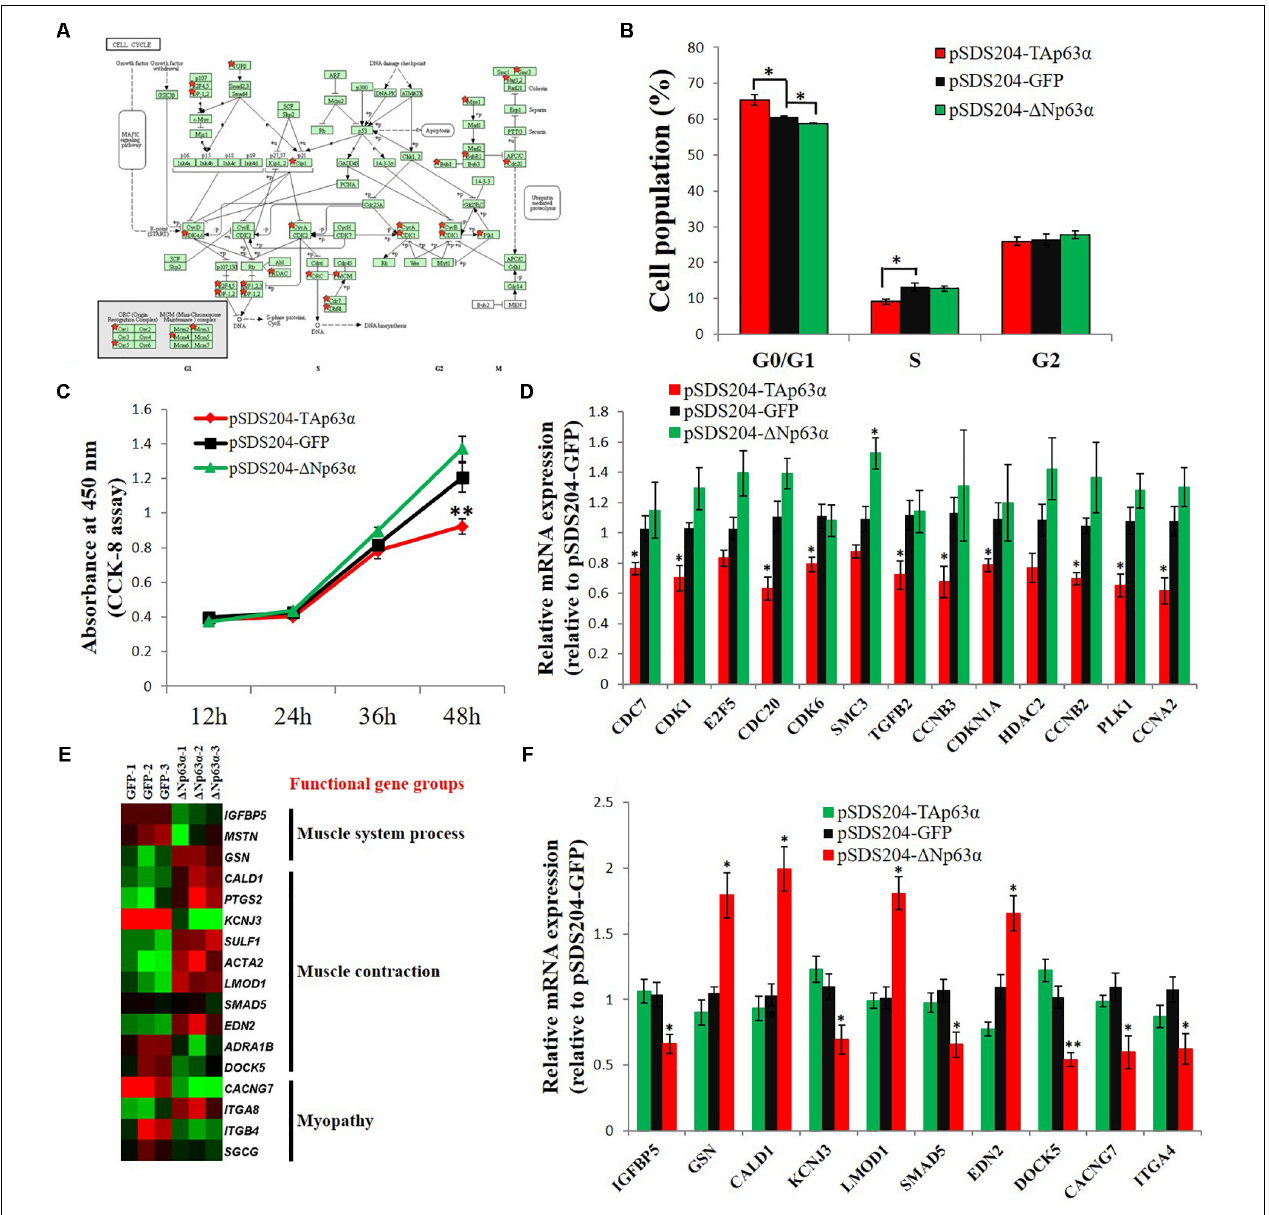
FIGURE 5 | Identification of major downstream regulatory pathways and functional gene groups of TAp63 α and (cid:49) Np63 α in myoblasts. (A) DEGs between TAp63 α overexpression myoblast and NC myoblast were enriched in the cell cycle pathway. Red stars indicate the genes that are differentially expressed between TAp63 α and NC group. (B) Myoblasts were transfected with pSDS204-TAp63 α , pSDS204- (cid:49) Np63 α , or pSDS204-GFP, followed by 48 h culture, and the cell cycle phase was then analyzed. (C) CCK-8 assay was performed to access the effects of TAp63 α and (cid:49) Np63 α overexpression on myoblast proliferation. (D) qPCR validation of the DEGs enriched in cell cycle pathway. (E) The heat-map of genes related to muscle system process, muscle contraction, and myopathy. (F) qPCR validation of the DEGs related to muscle system process, muscle contraction, and myopathy. The data are the mean ± SEM of three cultures per group, and three wells per culture were assayed ( n = 9/treatment group). An independent samples t -test was used to analyze the statistical differences between groups. ∗ p < 0.05; ∗∗ p <